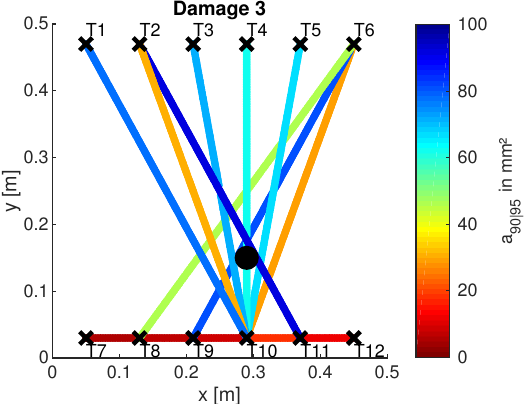
Figure 18. Visualisation of the a 90 | 95 values along different paths. A circle ◦ marks the damage position; the crosses × mark transducers. The evaluation was done for DI Energy at f = 40 kHz and a dec = 0.01.